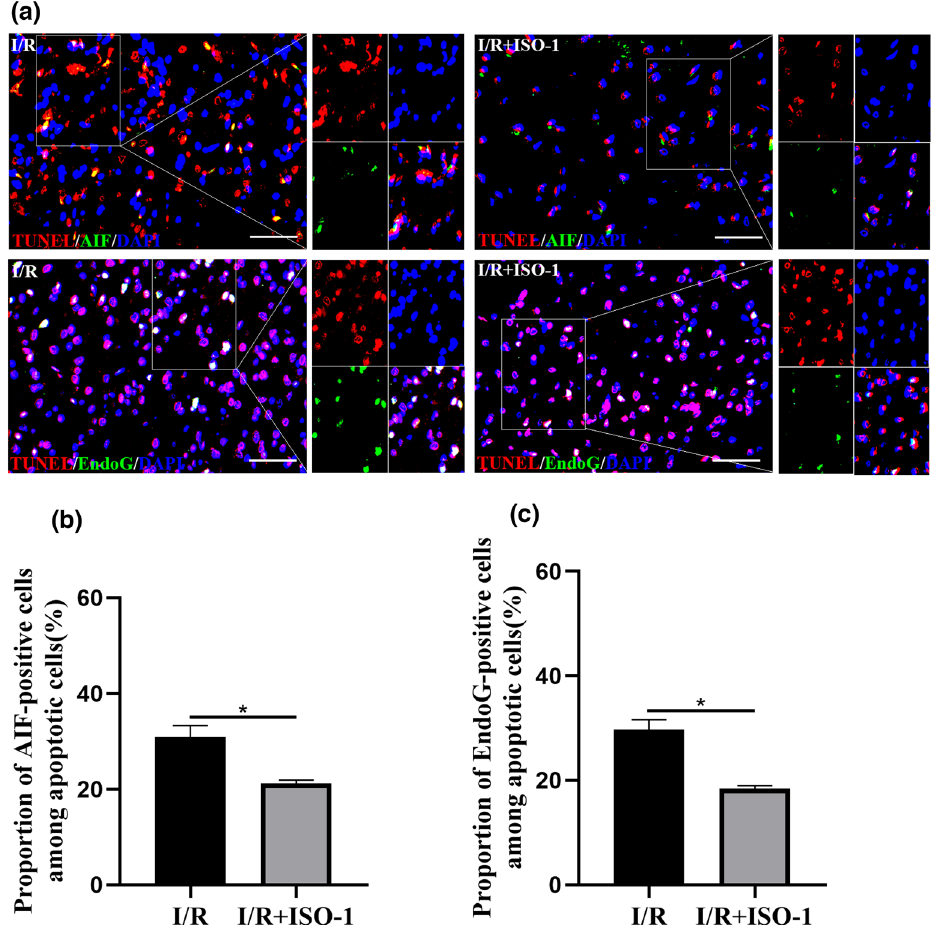
Figure 7. The colocalization of AIF and EndoG in apoptotic cells was detected by TUNEL and immunofluorescence staining. ( a ) Immunofluorescence staining of AIF (green), EndoG (green), DAPI (blue) and apoptotic cells (red). ( b , c ) The proportion of the number of TUNEL-positive cells showing the transfer of AIF and EndoG, which was from mitochondria to nucleus, to the total number of TUNEL-positive cells in different groups. * P < 0.05, bar 50